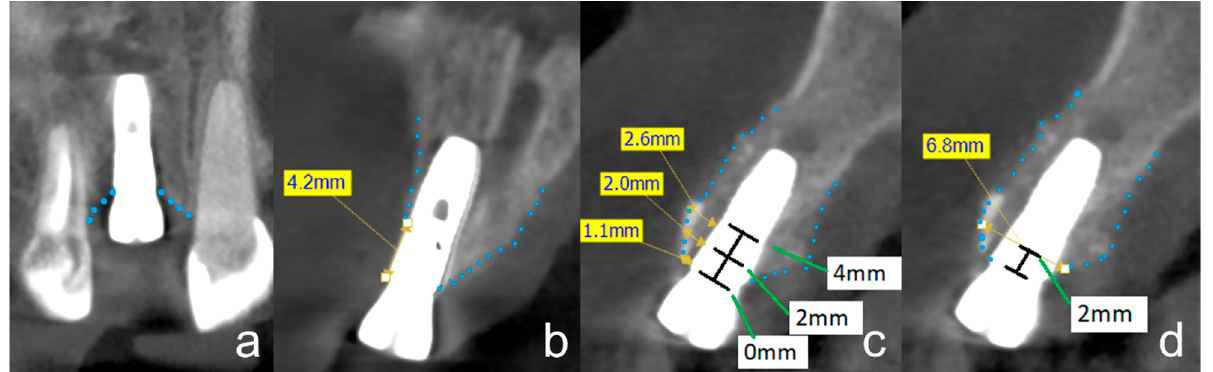
Figure 4. Three-dimensional Cone beam view of implant exposure one quarter after placement. The marked representation circumscribes the jaw area: ( a ) Time of implant exposure; ( b ) Lateral view to assessing the buccal lamella. Implant shoulder to hard tissue (buccal lamella resorption of 4.2); ( c ) Buccal lamella and its width. The lateral tooth shell is unmistakably visible. Measurements were taken at several levels (L0 = 0 mm, L2 = 2 mm, and L4 = 4 mm); ( d ) The dimension of the buccal jaw lamella was measured in the CBCT (L2, width = 6.8 mm).